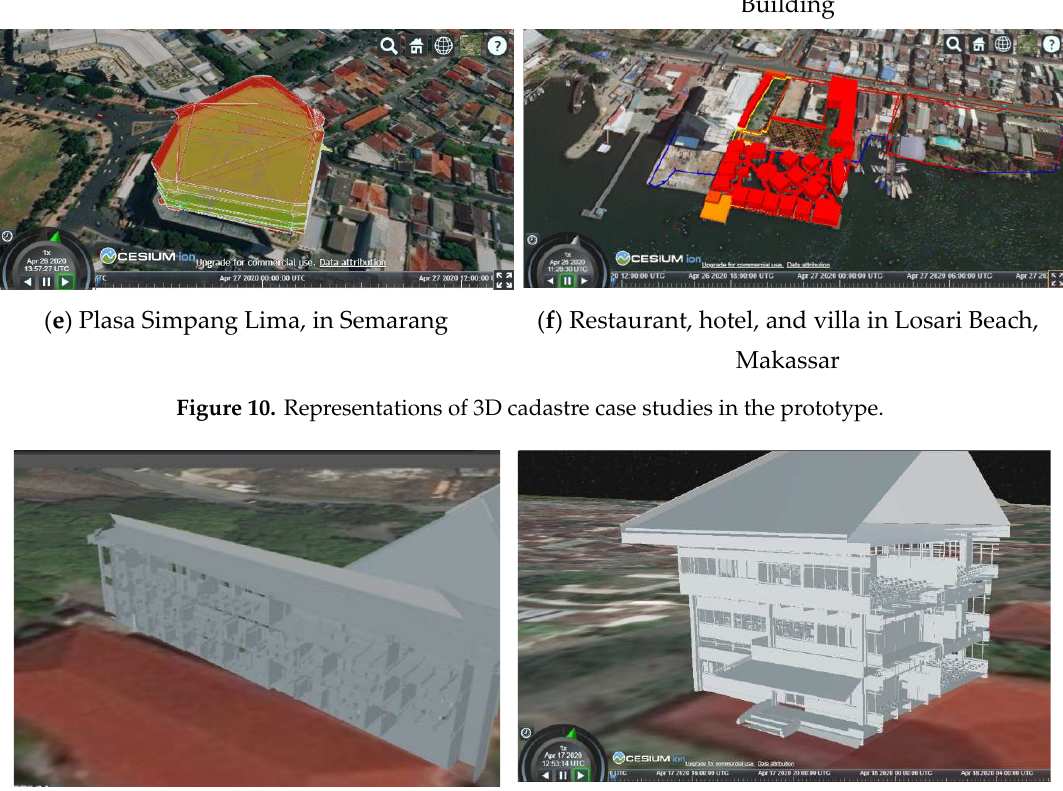
Figure 11. Cross-section view of object (d) using Cesium JS in the prototype from the south east view ( left ) and the north west view ( right ).